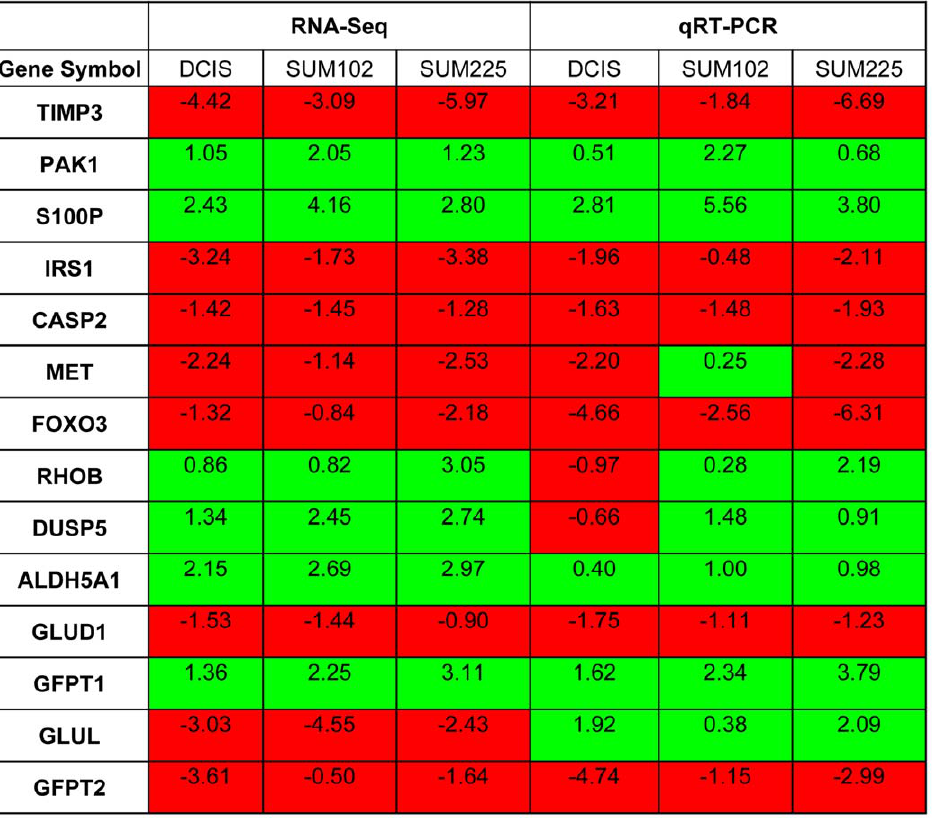
Figure 4. Comparison of the changes in expression of selected genes detected by RNA-Seq and qRT-PCR. The values represent log 2 fold change in MCF10.DCIS, SUM102 and SUM225 compared to expression in MCF10A. Positive values indicate up-regulation (highlighted in green) and negative values indicate down-regulation (highlighted in red).